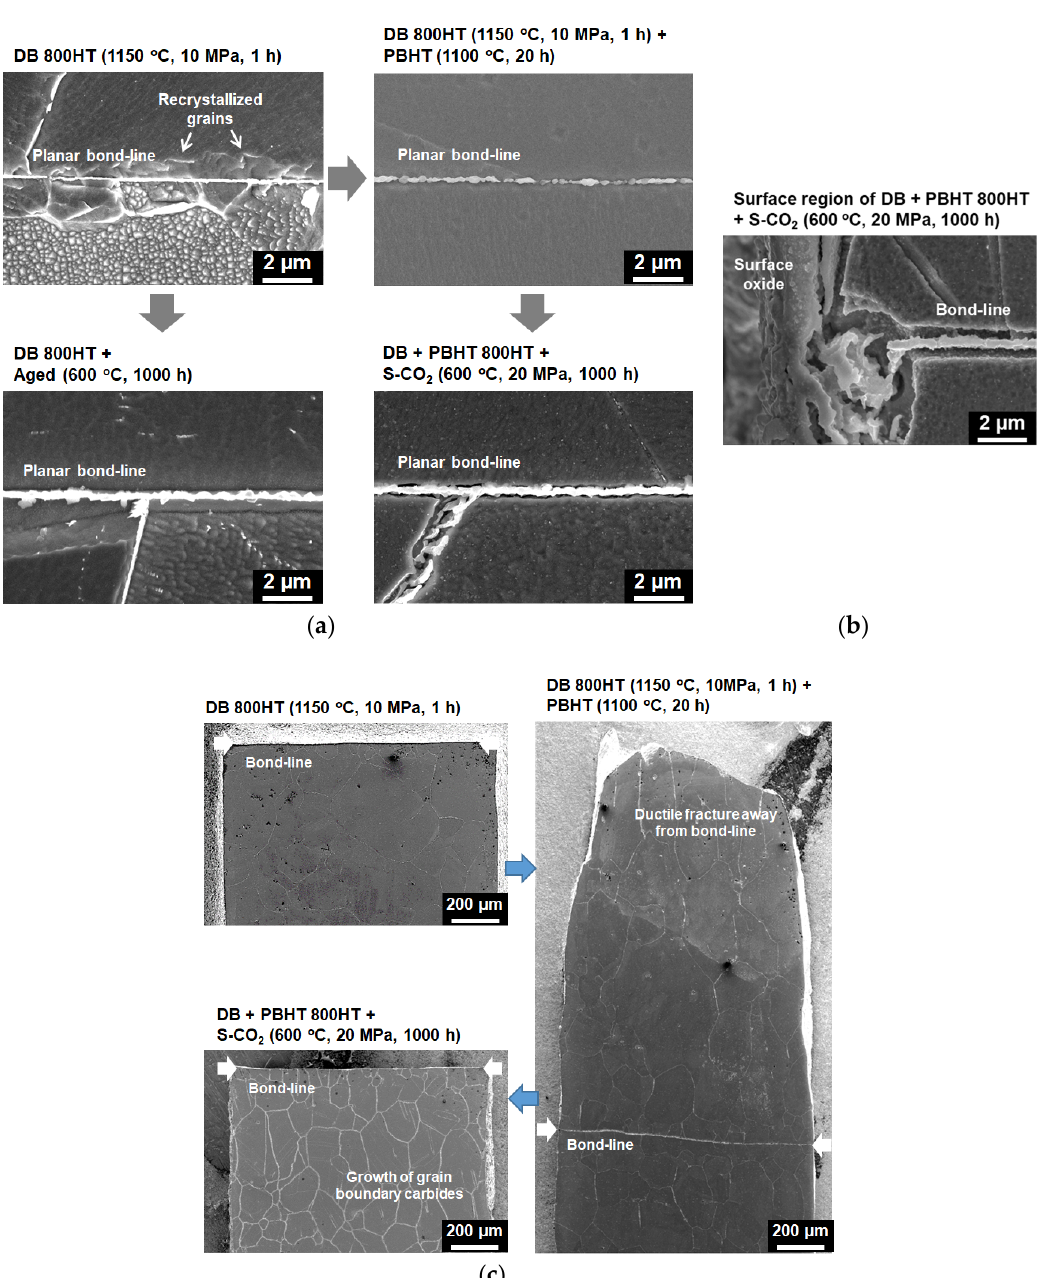
Figure 11. SEM micrographs of ( a ) at the middle and ( b ) surface of diffusion bonded joints, and ( c ) tensile ‐ tested specimens of diffusion bonded Alloy 800HT before and after S ‐ CO 2 exposure at 600 °C (20 MPa) for 1000 h.